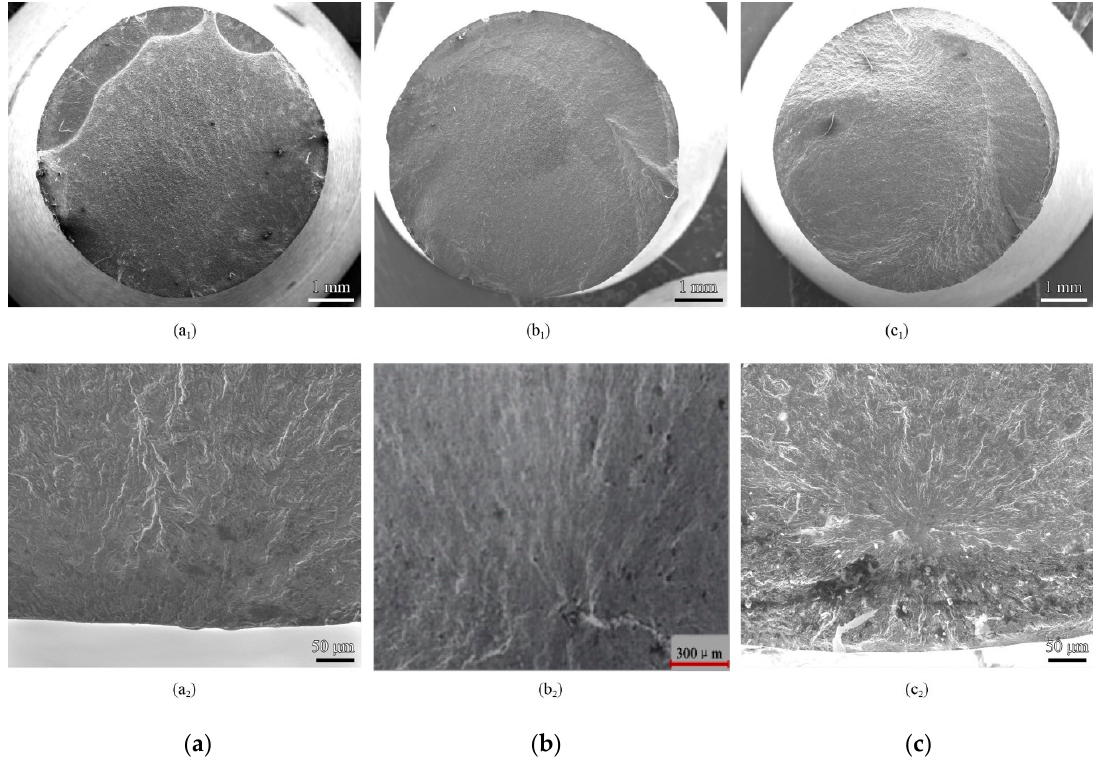
Figure 6. Fractograph of fatigue fracture ( a ) Un-surface strengthened specimen; ( b ) Shot peened specimen; ( c ) Nitrided specimen.